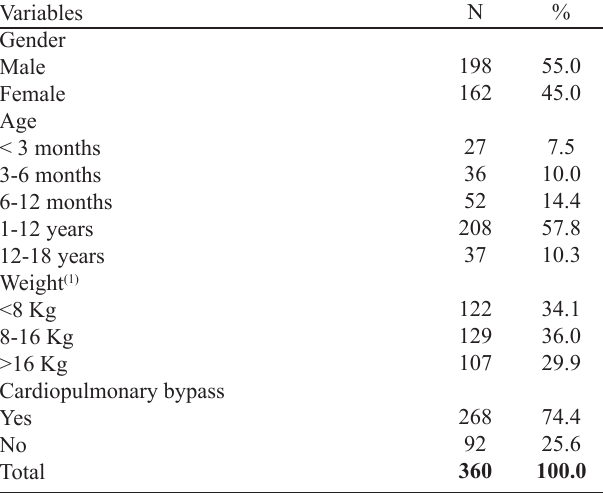
Table 1. Characteristics of patients.